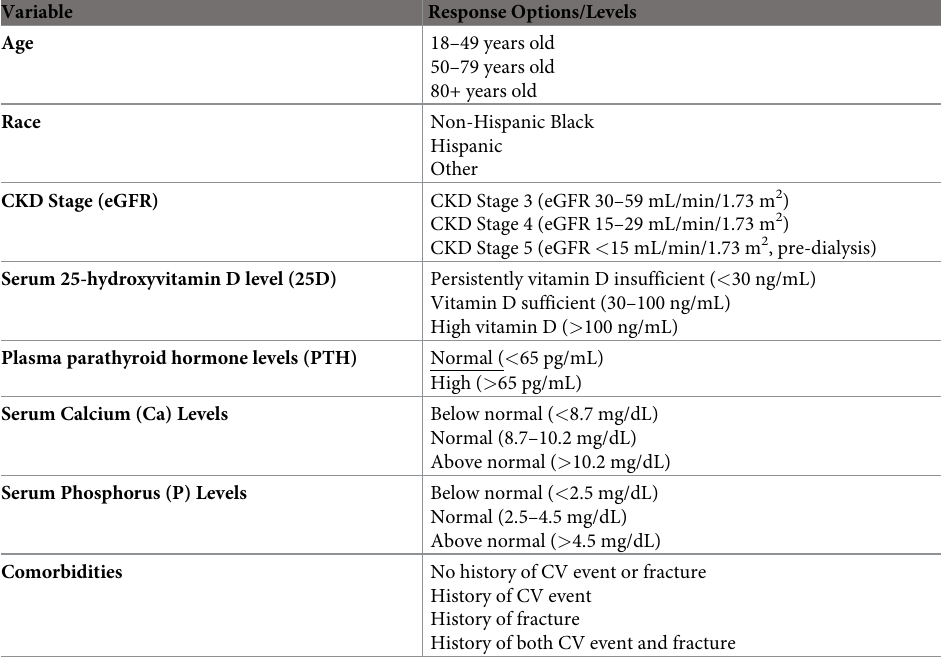
Table 1. Attributes and levels selected for conjoint